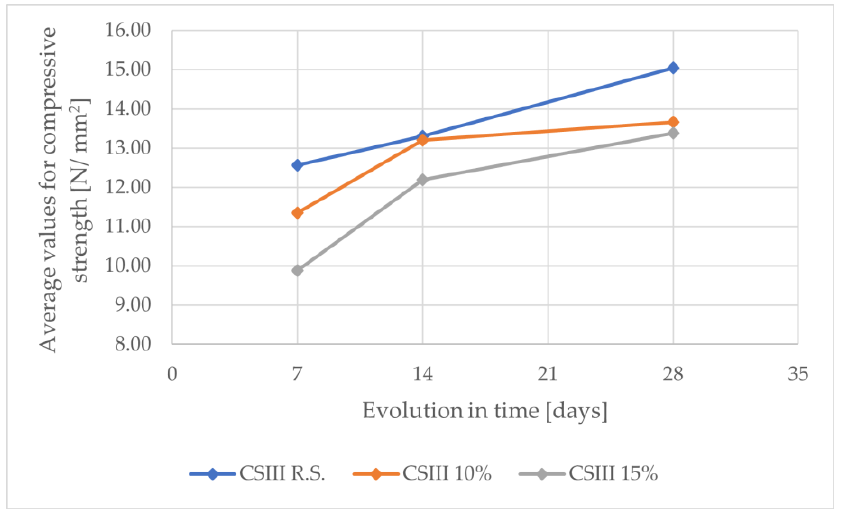
Figure 16. Compressive strength results.